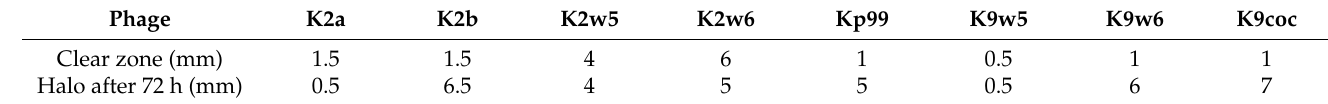
Table 2. General characteristics of the eight